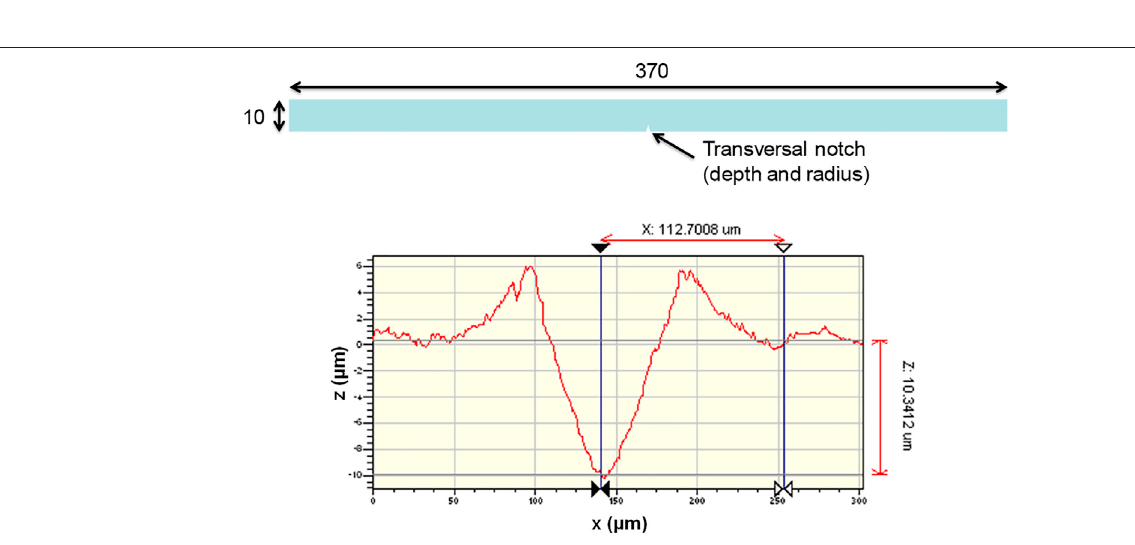
Frontiers in Materials |